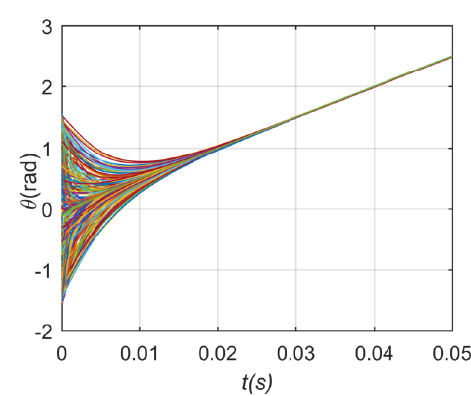
Figure 13. Phase stabilization process of undirected network in case 2.